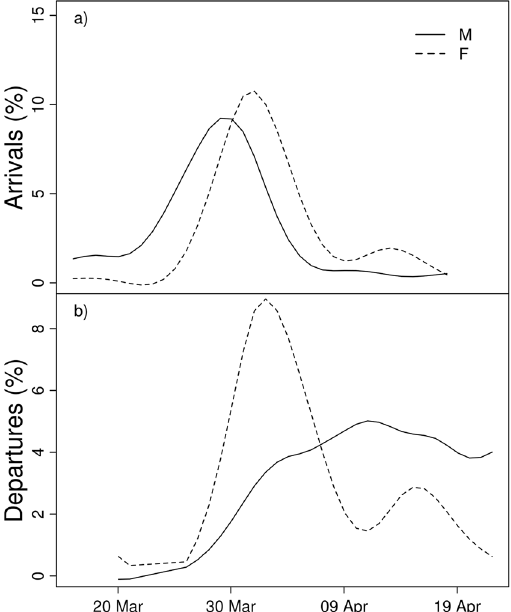
Figure 2. Arrival ( a ) and departure dates ( b ) in 2016 plotted for females (F) and males (M) separately. Lines in panels ( a ) and ( b ) represent the percentage of arriving and departing individuals in a given day. Raw data are provided in Supplementary Fig. S1.